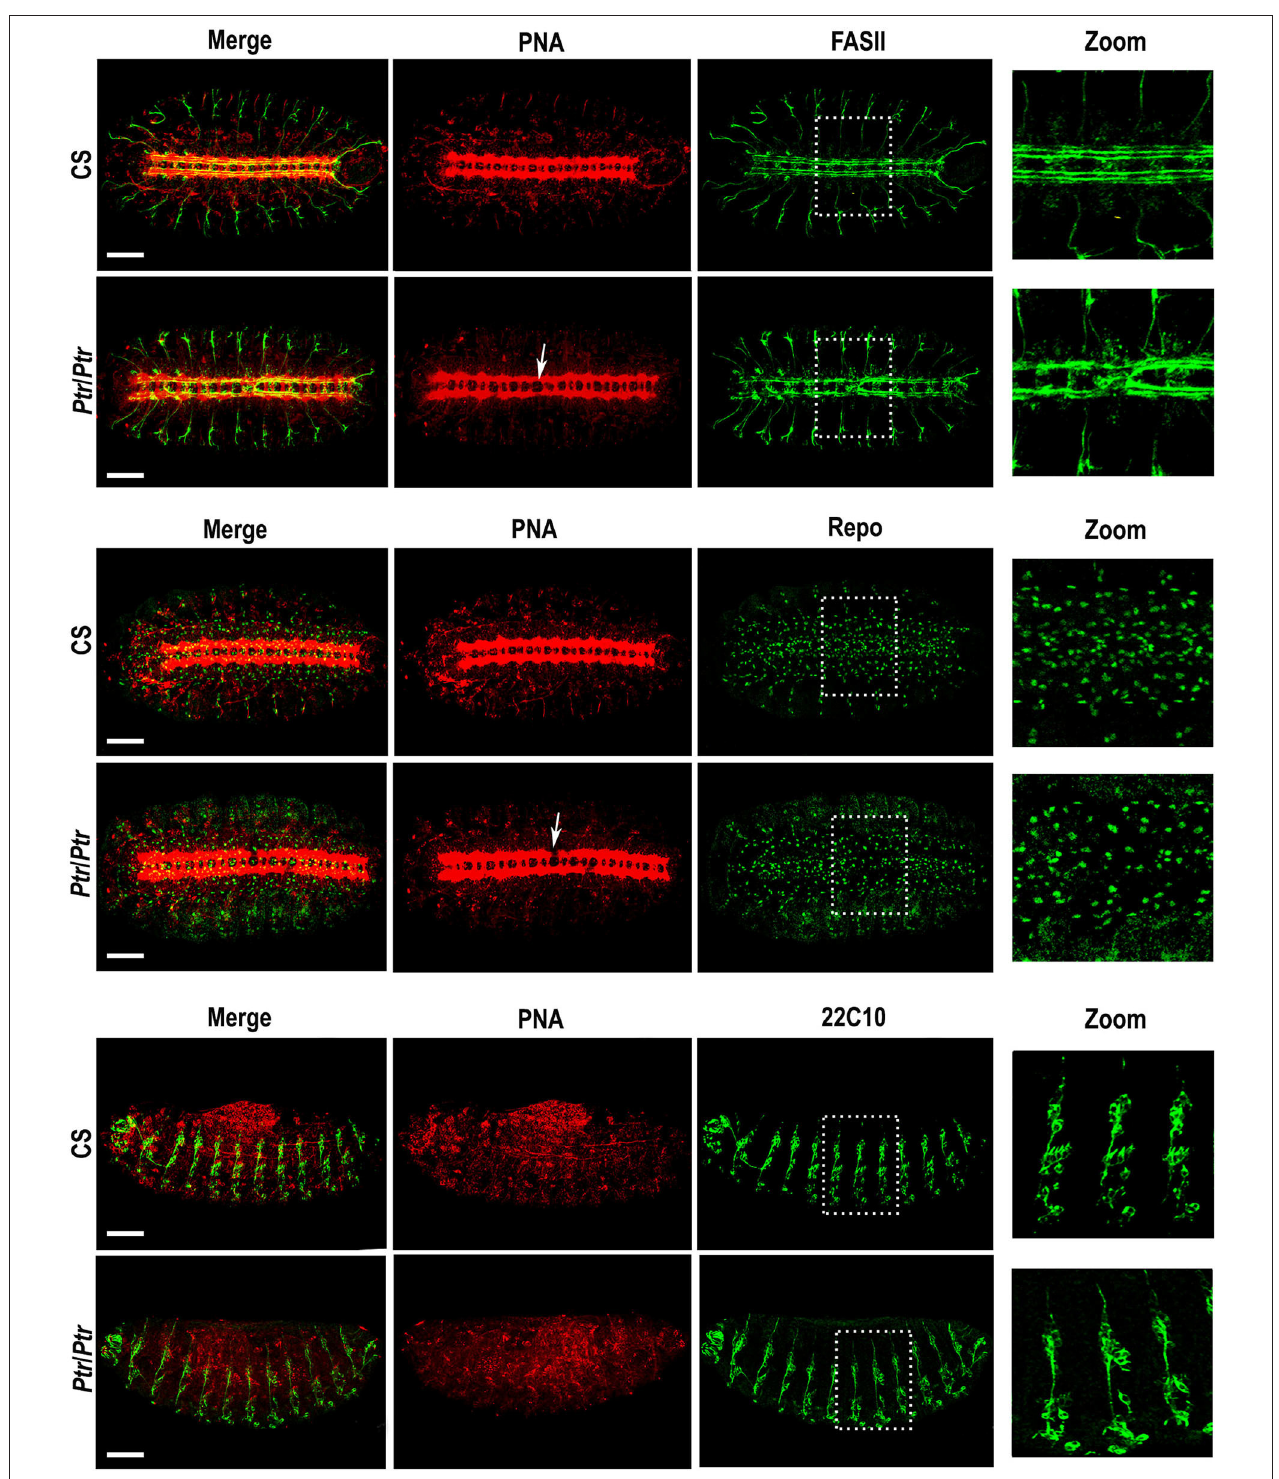
FIGURE 1 | Phenotypic analysis of the Ptr null mutant in whole mount embryos. Z-stack immunofluorescences against PNA and FASII (the two upper rows), PNA and Repo (the two middle rows) or PNA and 22C10 (the two bottom rows). The analysis was carried out on D. melanogaster late embryos (stage 15/16). Arrows indicate the alterations in the primary tracts of Ptr null mutants that were evidenced with PNA. The right column shows a higher magnification of the alterations found inside the dashed boxes in each image. In all the figures, embryos are oriented anterior to the left. To observe the nervous system, the first four rows of images are ventral views of the embryo, whereas, in the last two rows, the ventral side of the embryo is down. Bars: 50 µ m.